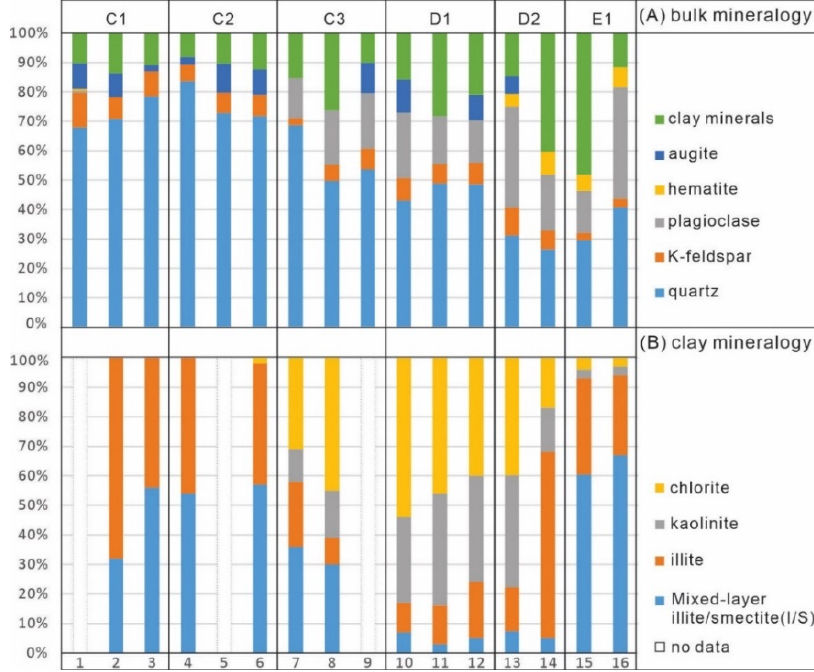
Figure 6. XRD major and clay mineral components.